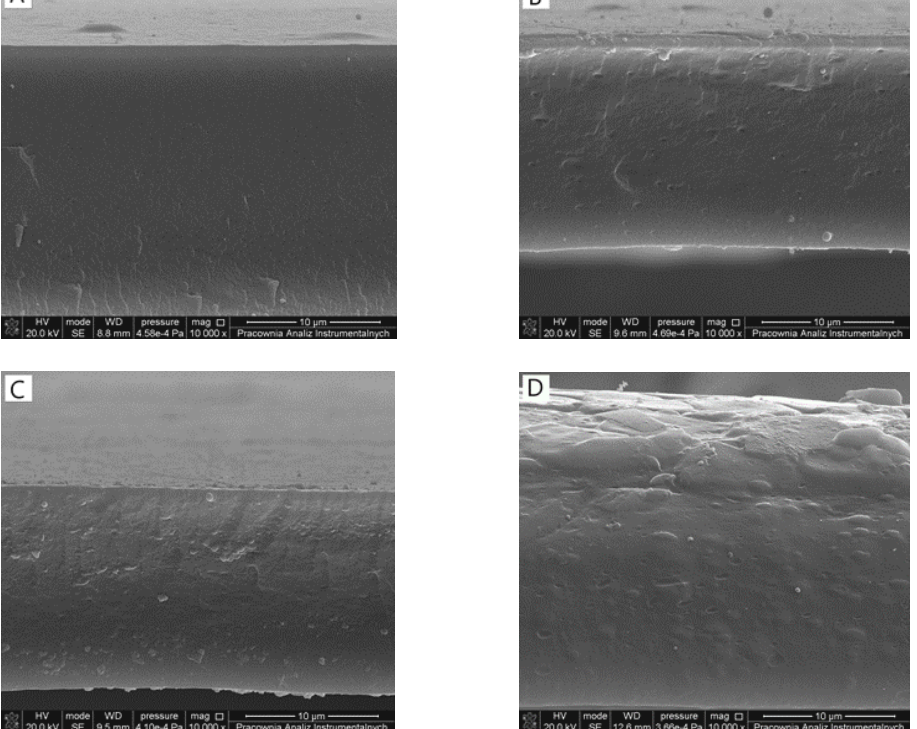
Figure 1. SEM images of ( A ) 100SA ( B ) 90SA/10TA ( C )80SA/20TA ( D ) 70SA/30TA .